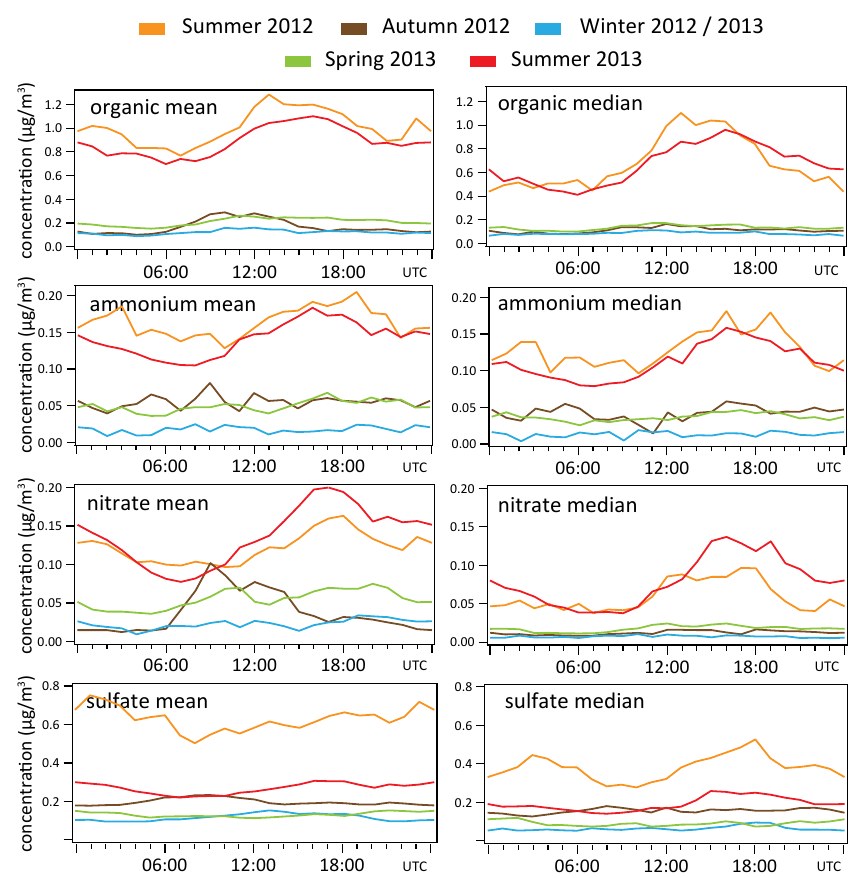
Figure 3. Seasonal diurnal plots for organics, ammonium, nitrate and sulfate (from top to bottom) in µgm − 3 . On the left: mean diurnal concentrations; on the right: median diurnal concentrations. The different traces show the seasons: summer 2012 in orange, autumn 2012 in brown, winter 2012/2013 in blue, spring 2013 in green and summer 2013 in red. Times are shown in